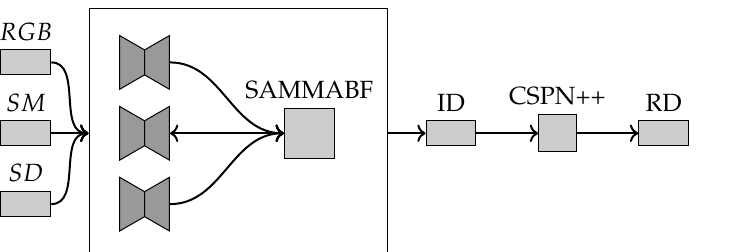
Figure 8. The inputs shown on the left are the RGB image, the semantic map computed from the RGB image and the sparse depth captured by the LiDAR sensor. The features from the three-branch backbone are fused using the semantic-aware multi-modal attention-based fusion block (SAMMABF) and will output the initial depth map shown as ID . This is refined with the CSPN++ [14] with dilated convolutions [42] to output the refined depth map shown as RD .